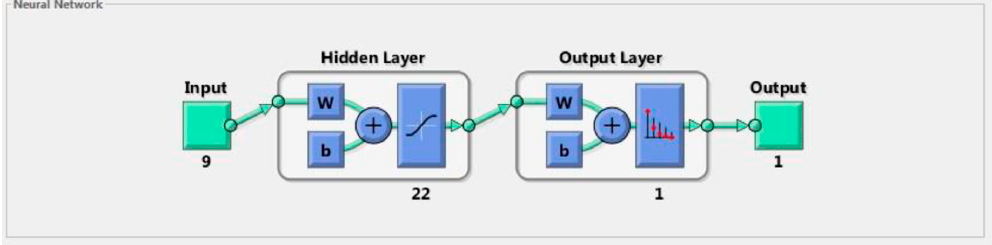
Figure 6. General structure of the applied neural network using polynomial coefficients with the degree N = 2.